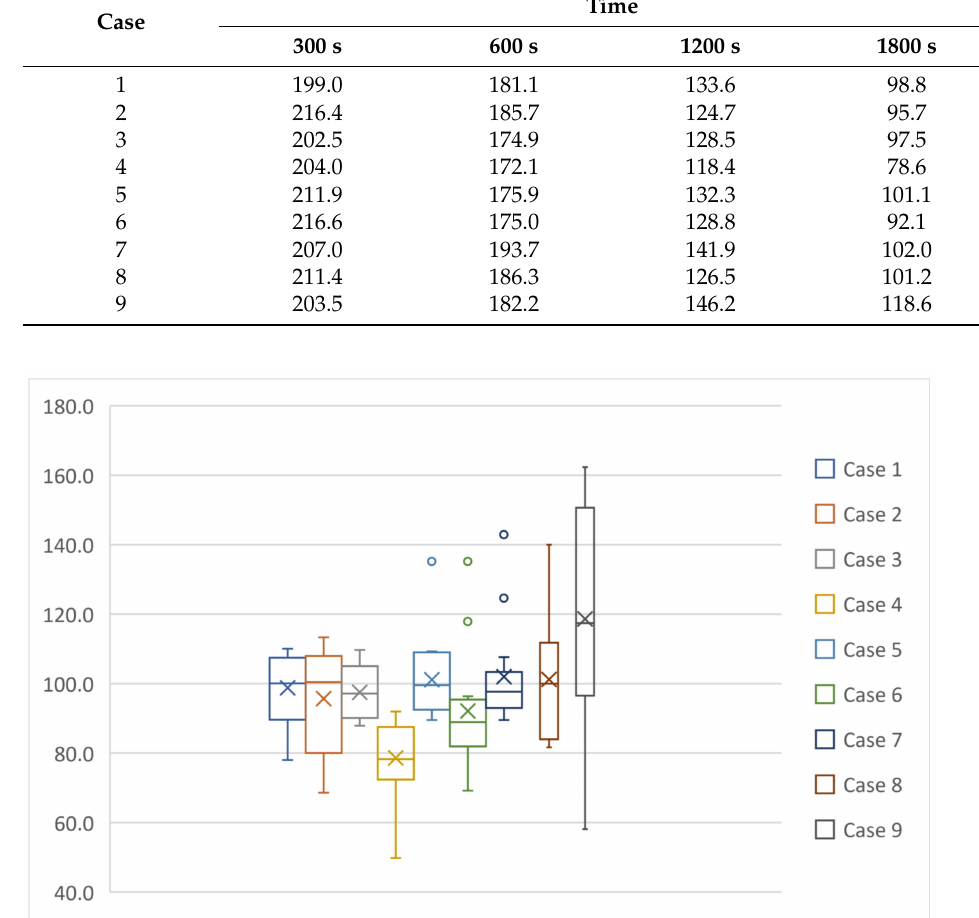
Figure 6. Quantitative results of the nine cases at 1800 s. It can be seen from Figure 6 that case 4 achieved the lowest average air pollution concentration of 78.6 µ g/m 3 at the end of the experiment, while case 9 ends up with the highest air pollution concentration of 118.7 µ g/m 3 , indicating that the concentration of PM2.5 decreased most in the simulation of case 4. The overall decrease of concentration of PM2.5 in case 4 was 33% higher compared with case 9, meaning that the best location of the air purifier can increase the efficiency by up to 33% compared with other locations. Figure 7 plots the concentration of the air pollution concentration along with the time for all cases within 30 min. It can be shown that the overall performance of case 4 was outstanding over other cases during the entire